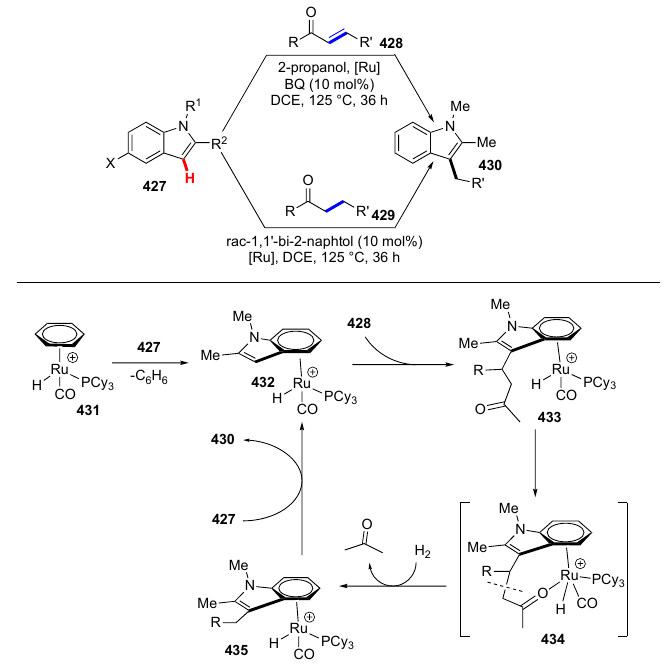
Scheme 55. Ru-catalyzed C3–H alkylation of indoles.